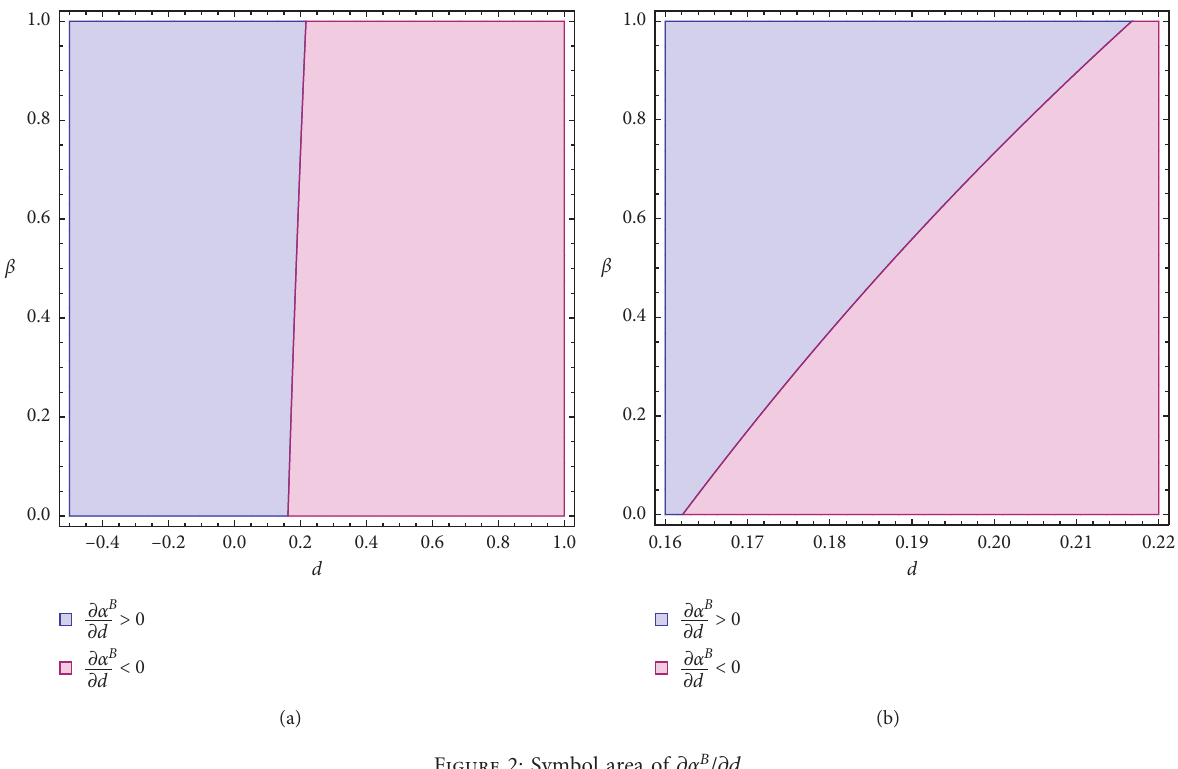
Figure 2: Symbol area of z α B / z d